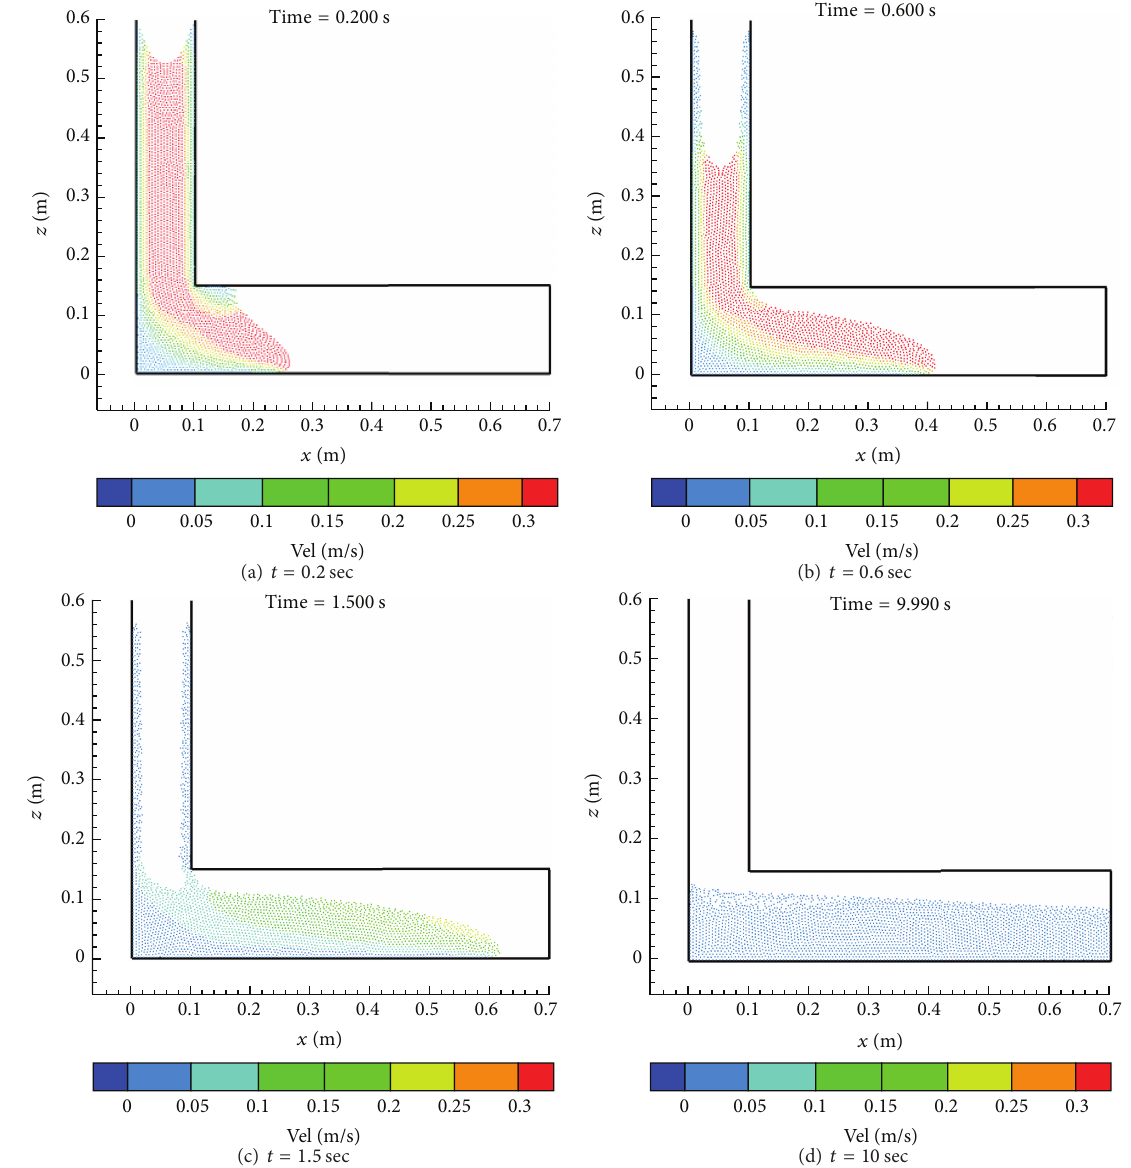
Figure 6: Simulation of L-box testing for SCC with velocity